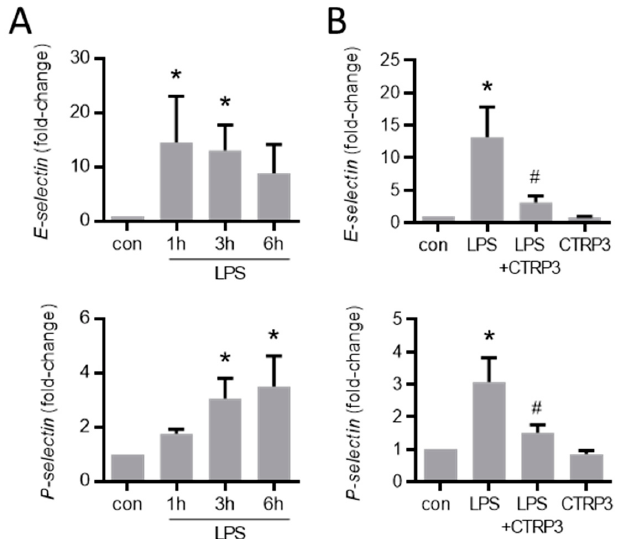
Figure A2. LPS-induced endothelial adhesion molecule expression is inhibited by CTRP3. ( A ) MyEnd (myocardial endothelial) cells were stimulated with LPS (50 ng/mL) for the indicated period. E-selectin and P-selectin mRNA levels were analyzed by real-time PCR. * p < 0.05 vs. con = unstimulated control, n = 4–6. ( B ) MyEnd cells were stimulated with LPS (lipopolysaccharides, 50 ng/mL) alone or pretreated with CTRP3 (C1q/TNF-related protein 3, 10 µg/mL, for 30 min) and with CTRP3 alone for 3 h. E-selectin and P-selectin mRNA levels were analyzed by real-time PCR. * p < 0.05 vs. con = unstimulated control, # p < 0.05 vs. LPS, n = 4–6.